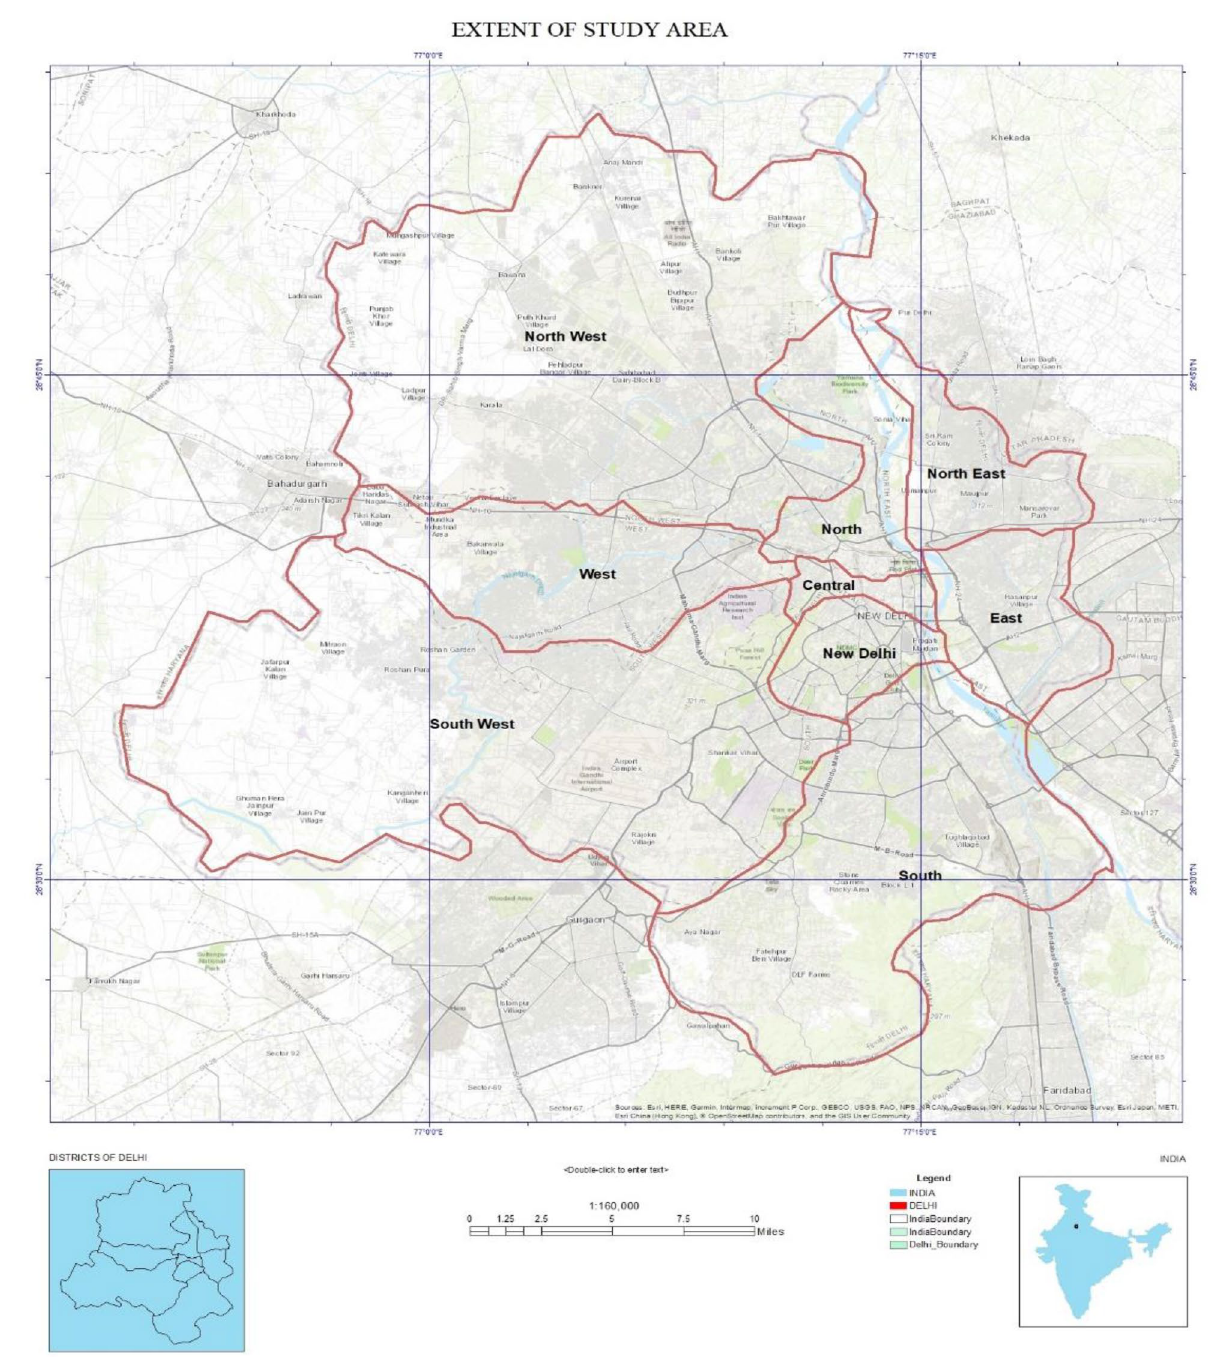
Figure 1. The extent of the study area (Map created with Arc Desktop 10.x